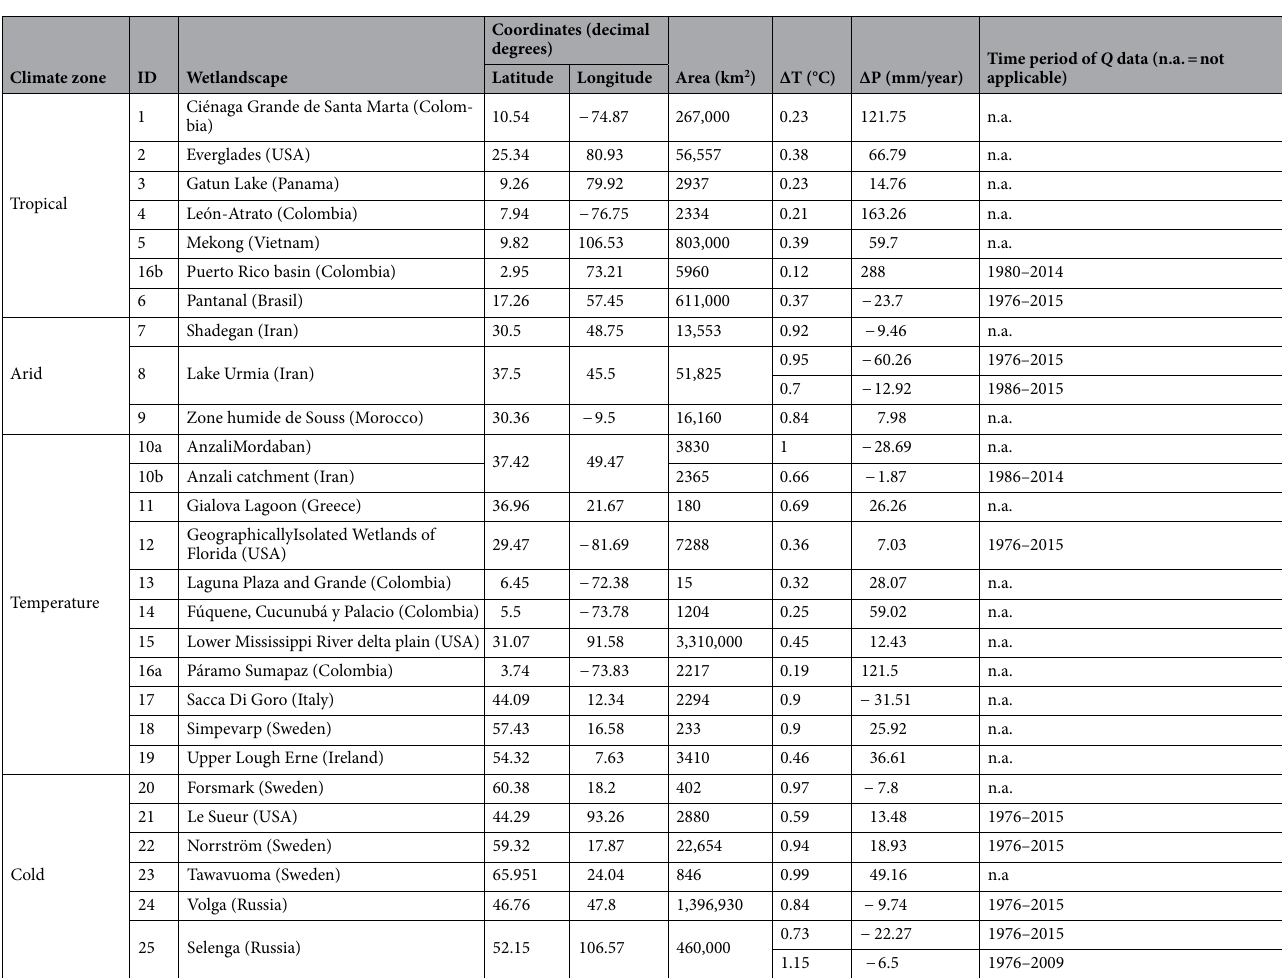
Table 1. Data overview of the studied wetlandscapes. Table showing the 25 studied wetlandscapes and their corresponding climate zone as well as their ID number, coordinates, name and size. In addition, the change in average temperature and average precipitation (∆T and ∆P) between the first half and the second half the studied time period(s) (1976–2015, or as given in the last column) is presented, as well as the time period of Q data